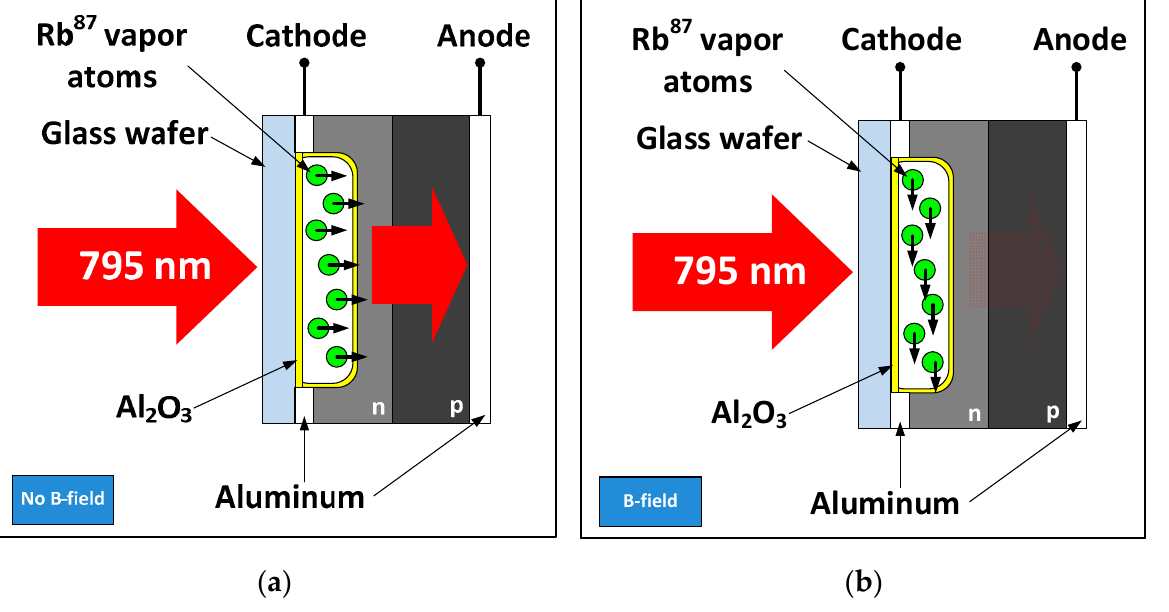
Figure 1. Representation of the MOEMS-based OPM: ( a ) without magnetic field; ( b ) with magnetic fi eld.